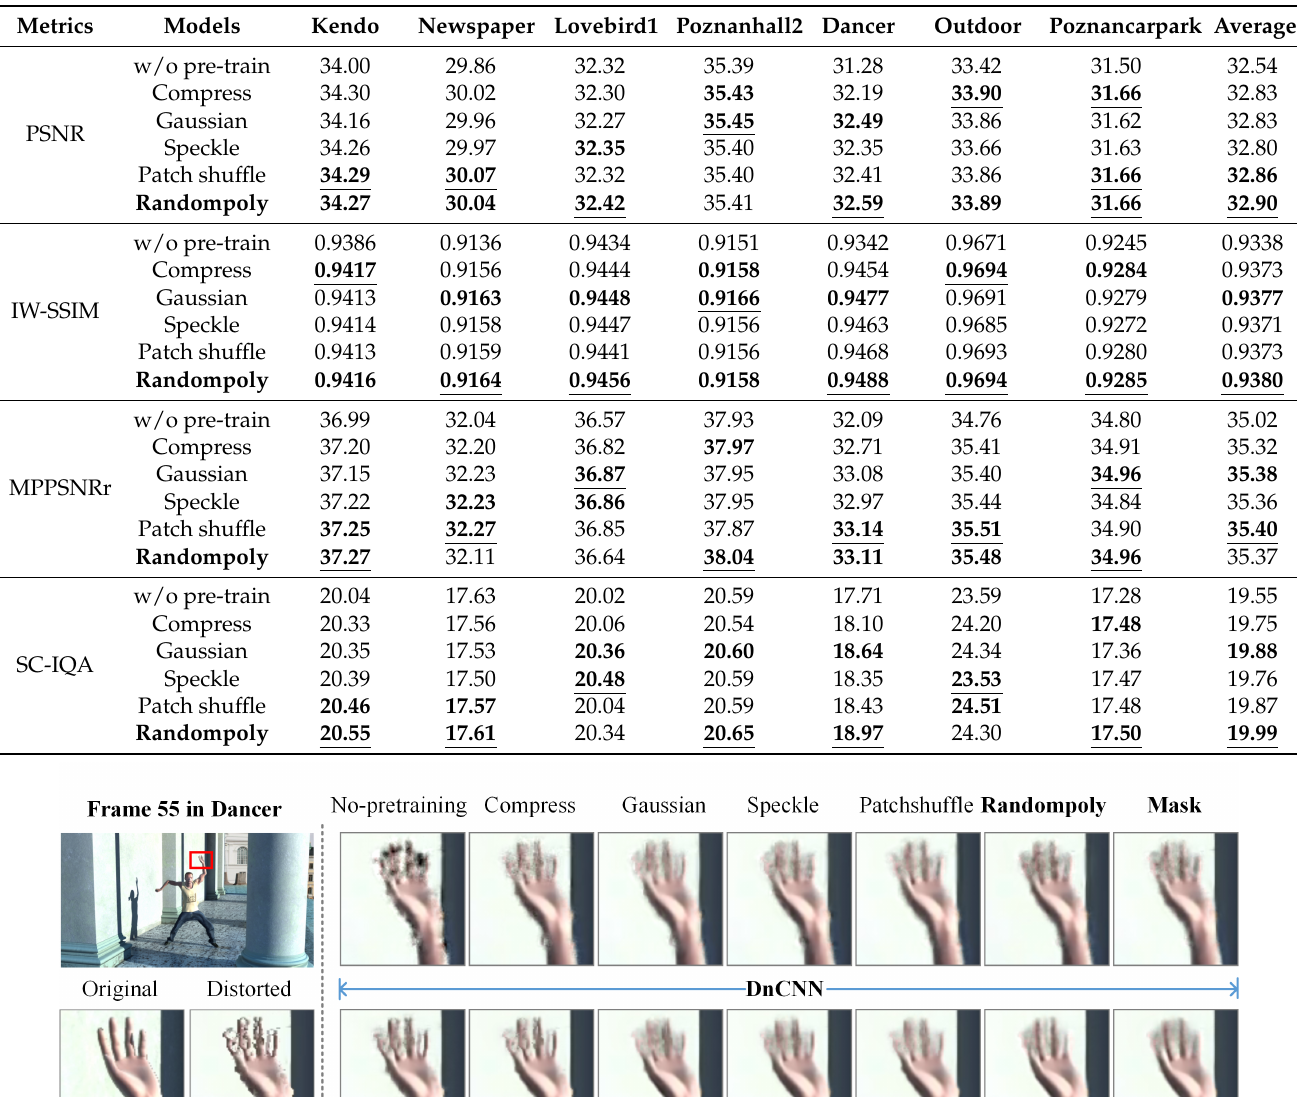
Table 5. SVQE performance comparison of NAFNet on Sess-H.264 by pre-training on synthetic synthesized image database with different random noise types generated from NYU database. ‘Randompoly’ is the proposed DIBR distortion simulation method and highlighted. The best and second results are highlighted in bold and the best results are underlined again.